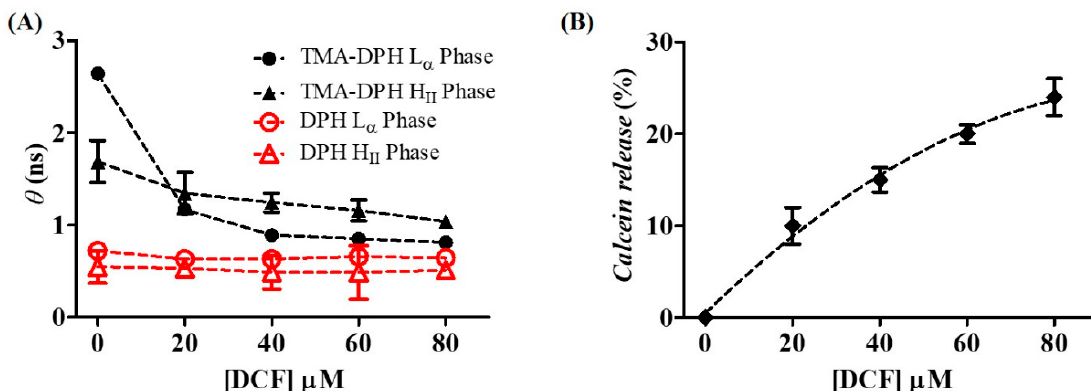
Figure 5. ( A ) Rotational correlation time ( θ ) of TMA-DPH (closed black symbols) and DPH (open red symbols) in DOPC:DOPE:CL (1:1:1) liposomes at L α phase (circles) and H II phase (triangles) as a function of DCF concentration. ( B ) Calcein release from DOPC:DOPE:CL (1:1:1) liposomes at L α phase as a function of DCF concentration. Calcein release (%) was calculated according to Equation (7). Results are representative of at least three independent determinations ± standard deviation. Dashed lines are guidelines only.